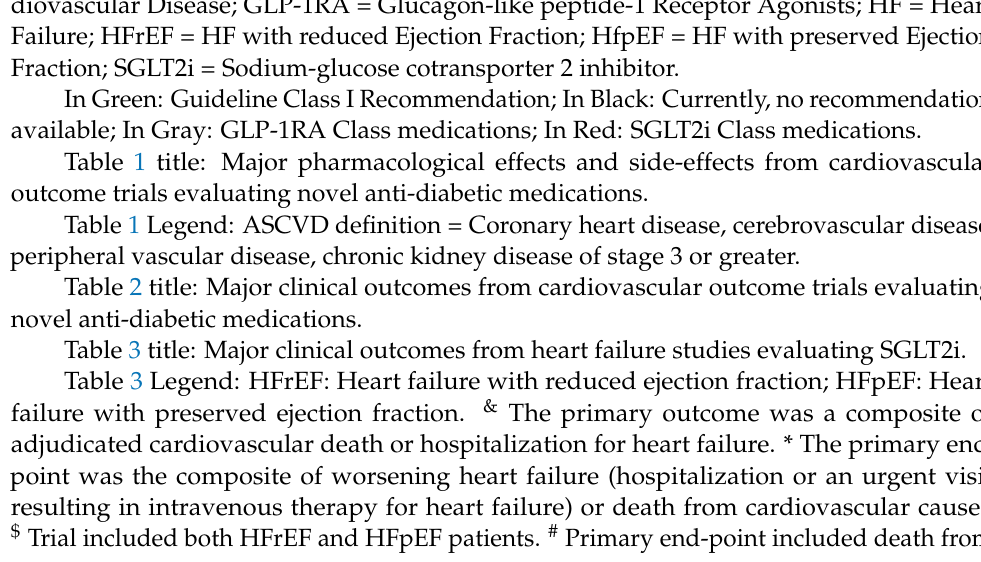
Figure 1 title: The various indications as well upcoming and future perspectives for novel diabetes medications for the cardiovascular patients, for both diabetic as well as non-diabetic, patients. Figure 1 legend: ACS = Acute Coronary Syndrome; ASCVD = Atherosclerotic Car- diovascular Disease; GLP-1RA = Glucagon-like peptide-1 Receptor Agonists; HF = Heart Failure; HFrEF = HF with reduced Ejection Fraction; HfpEF = HF with preserved Ejection Fraction; SGLT2i = Sodium-glucose cotransporter 2 inhibitor.